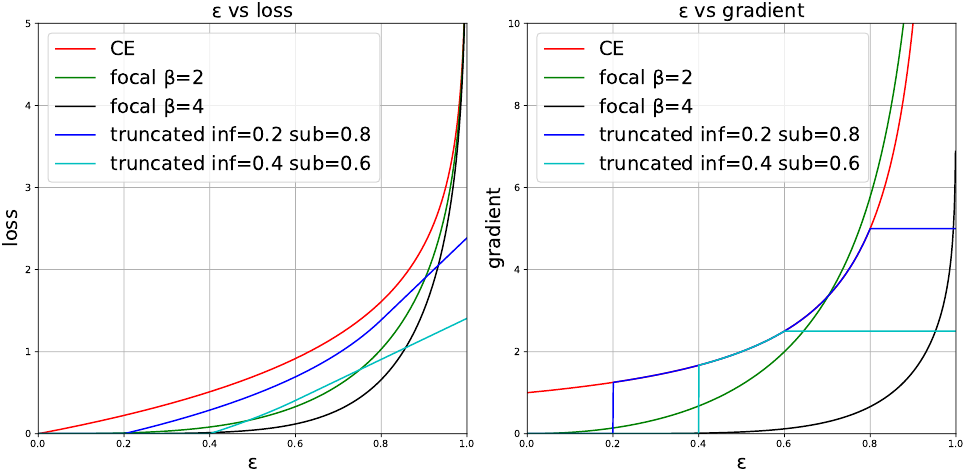
Figure 4. A comparison of the loss value and the gradient of cross-entropy loss, focal loss ( β = 2 and β = 4) and our truncated cross-entropy loss ( inf = 0.2, sub = 0.8 and inf = 0.4, sub =